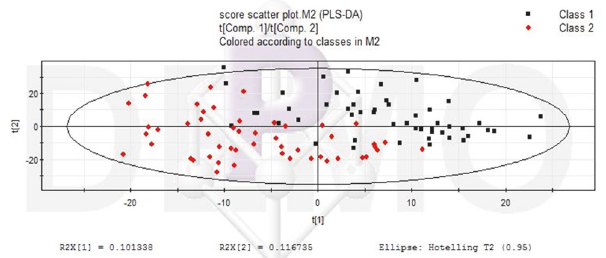
Figure 2: Scoring chart of PLS-DA pattern in treatment of liver fail- ure with nonbioartificial liver. Note. Class1, Before nonbioartificial liver treatment; Class2, After nonbioartificial liver treatment.